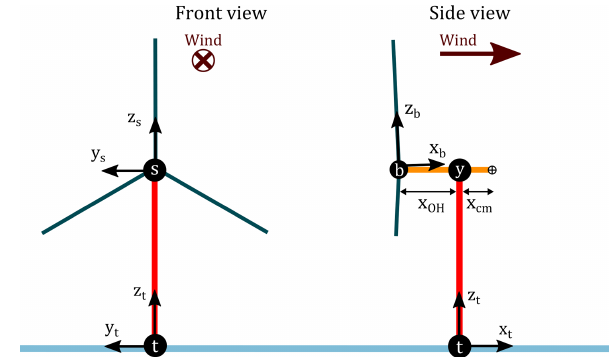
Figure 5. Illustration of the load axes used in this article. The non- rotating load axes – tower, main bearing, and yaw bearing – are all parallel and are denoted by subscripts “t”, “s”, and “y”, respectively. Note: the blade, hub, and main-bearing axis origins are collocated; the blade and hub load axes rotate with azimuth angle, as shown in Fig. 12. The CONR-13 is depicted to illustrate the rotor overhang x OH and nacelle center of mass x cm . The prevailing wind is positive in the same direction as the x t